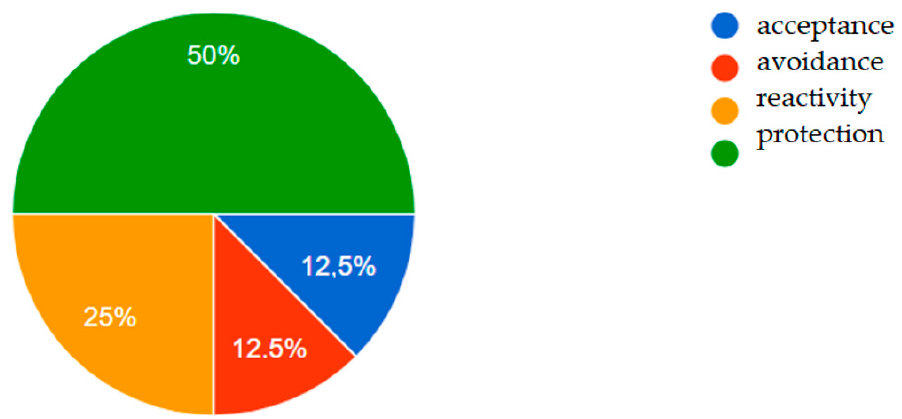
Figure 11. Strategies for dealing with supply chain disruptions.